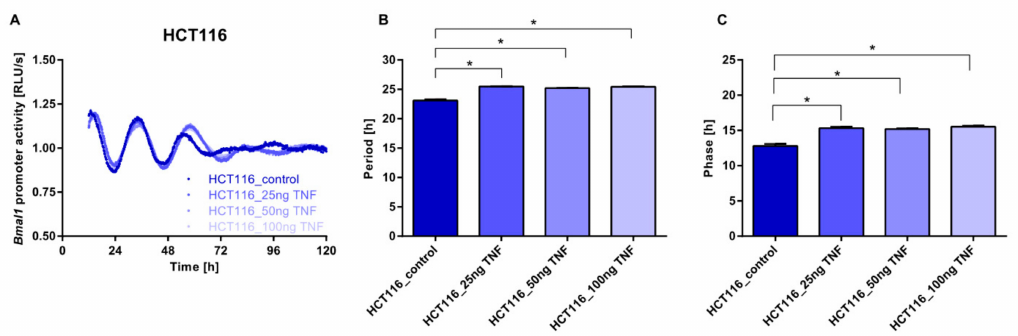
Figure 4. E ff ect of the stimulation with increasing amounts of human recombinant tumour necrosis factor (TNF) on circadian rhythms in HCT116 cells. HCT116 lentivirally transduced cells were cultured with increasing concentrations of human recombinant TNF (25, 50, and 100 ng / mL), and the BMAL1 -promoter activity was measured over five consecutive days ( A ). Shown is one representative replicate per condition. Colour gradients represent the di ff erent concentrations of recombinant human TNF used. Period ( B ) and phase ( C ) were calculated in the samples and comparisons were made to the control condition. Data are expressed as mean ± SEM, n = 3. Significant changes ( p < 0.05) between di ff erent conditions are marked with